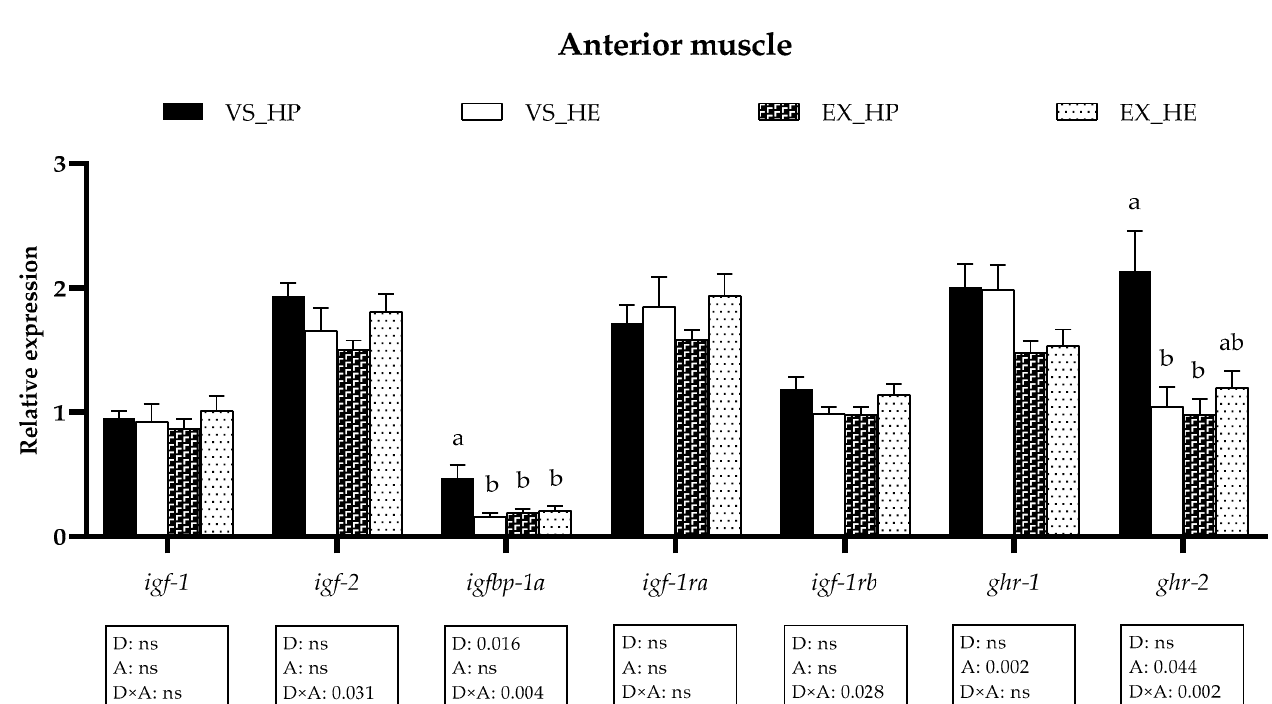
Figure 3. Relative gene expression of the GH-IGFs axis members in anterior muscle of fish under voluntary swimming (VS) or sustained exercise (EX) and fed with the high-protein diet (HP) or high-energy diet (HE). Data are shown as means + SEM. VS, n = 12; EX, n = 16. Factorial statistical analysis was assessed by two-way ANOVA, and p -values of factors diet (D), physical activity (A), and interaction (D×A) are displayed under the graph. Different letters indicate significant differences (Tukey’s post-hoc test, p < 0.05) .